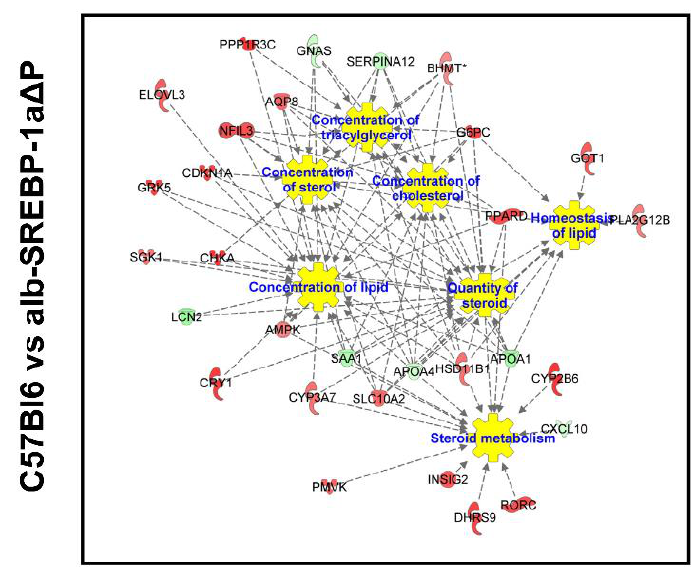
Figure 6. Functional network of SREBP-1-centered subnets. Differential abundant genes of the SREBP-1a subnet, the alb-SREBP-1a∆P subnet, and the phosphorylation subnet were used for IPA Core analyses. Color code indicates: red: increase in condition 1, green: decrease in condition 1 based on measured expression differences. Relation to pathophysiological function is indicated.